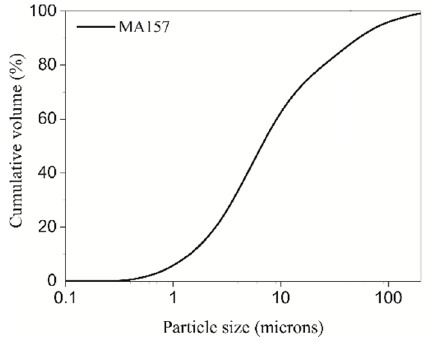
Figure 1. MA157 particle size distribution.